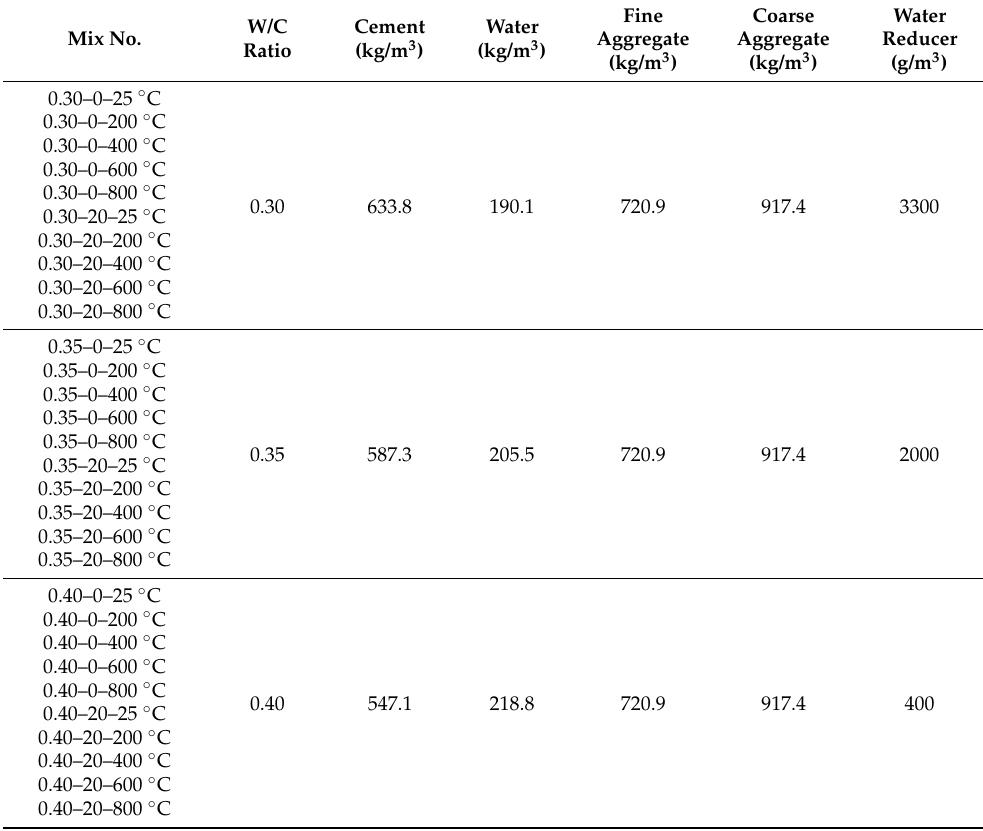
Table 1. Mix proportion of